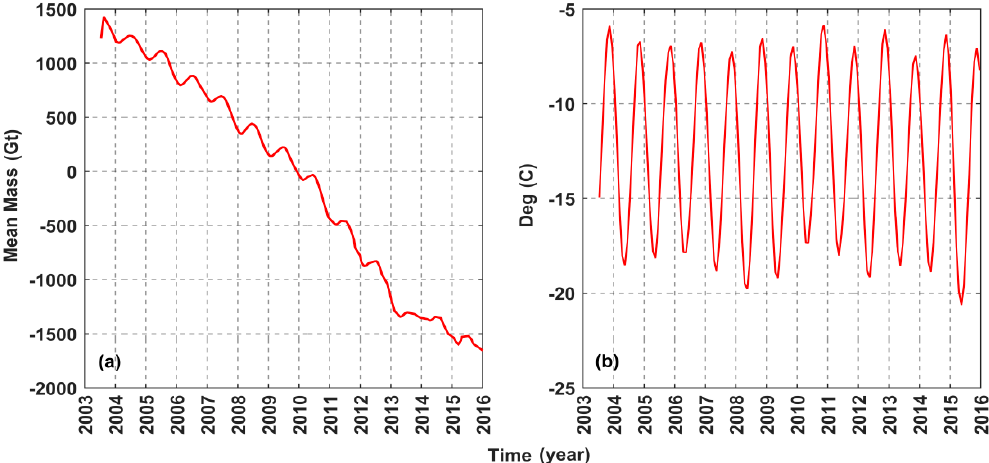
Figure 6. Annual changes of GRACE ice sheet mass and land surface temperature in Greenland from 2003 to 2015.